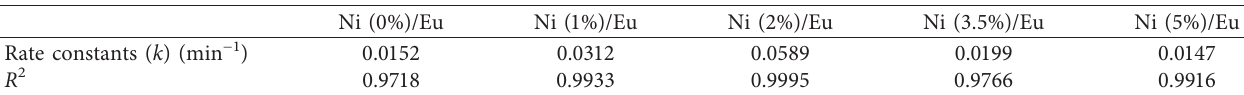
2 -Sb-Ni/Eu electrodes modified with various Ni